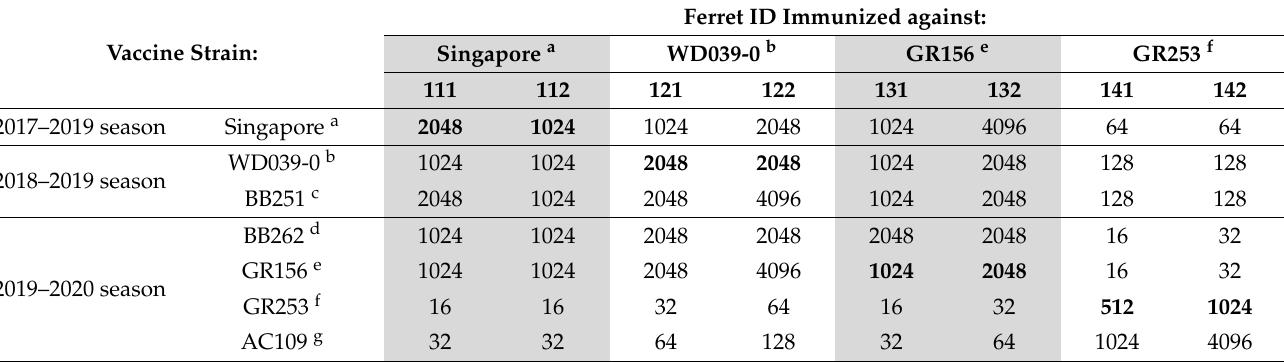
Table 2. Hemagglutination inhibition (HI) titers of ferret sera against A(H1N1)pdm09 viruses.